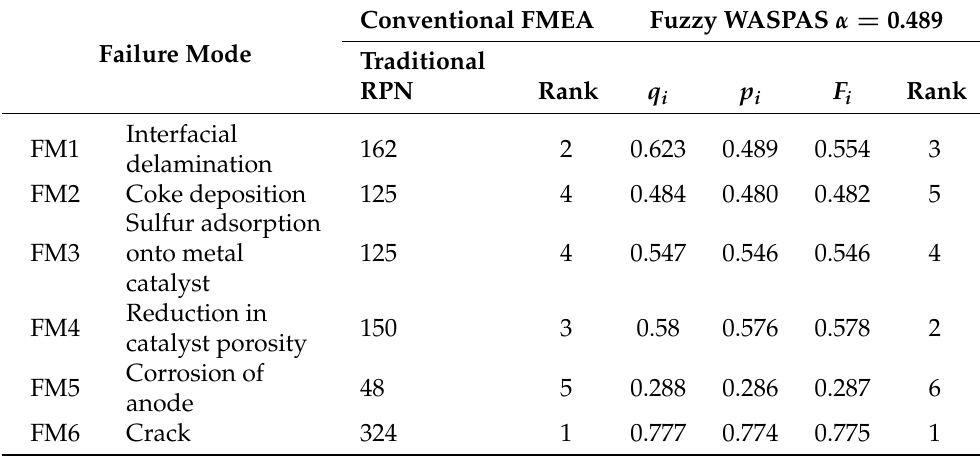
Table 12. SOFC failures modes